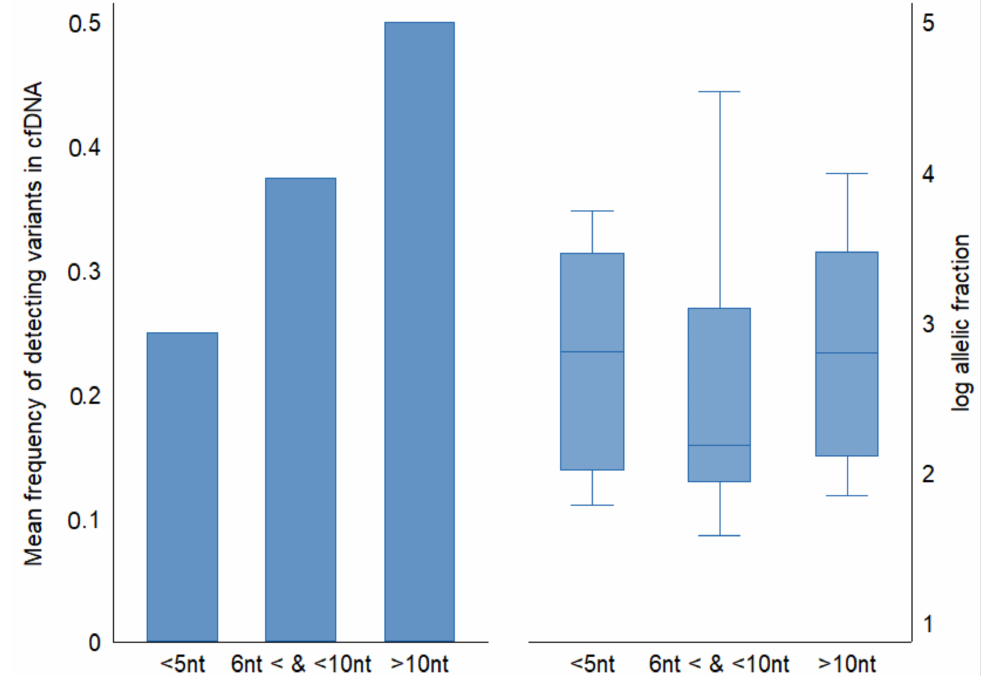
Figure 4. Comparison of frequency of detecting concordant variants in cfDNA relative to nucleotide distance between genetic coordinates of mutations in FFPE tumor tissue. Half of ESCC tumor TP53 mutations consisted of adjacent variants (<10 nt apart from the next mutation). Allelic fractions across groups were